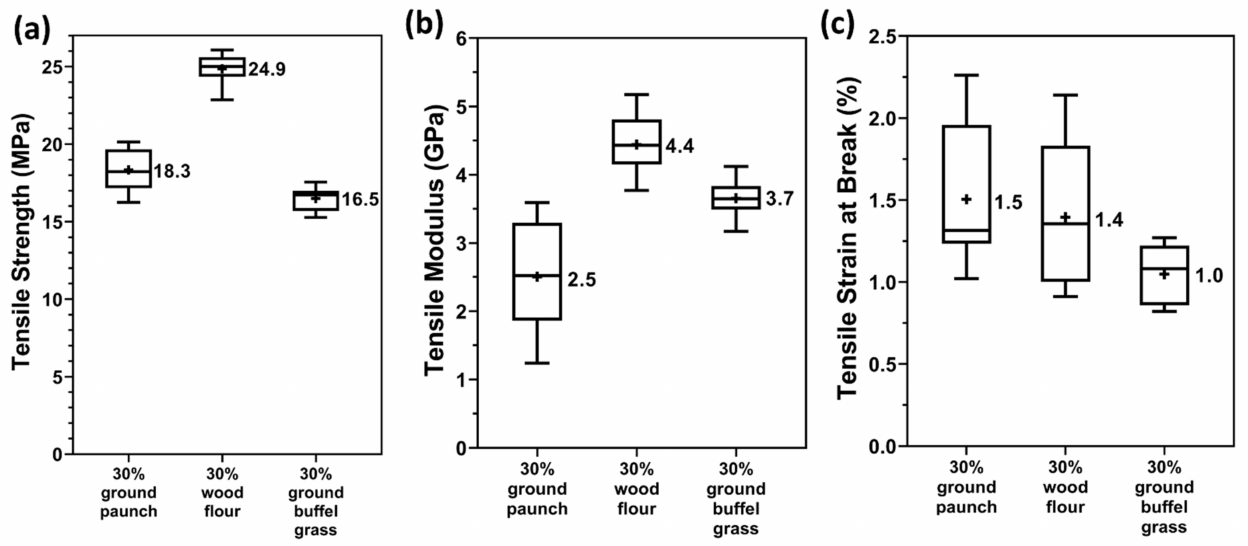
Figure 7. ( a ) Tensile strength, ( b ) tensile modulus, and ( c ) tensile strain at break of PHBV/ground paunch, PHBV/wood flour and PHBV/ground buffel grass composites at a fibre content of 30